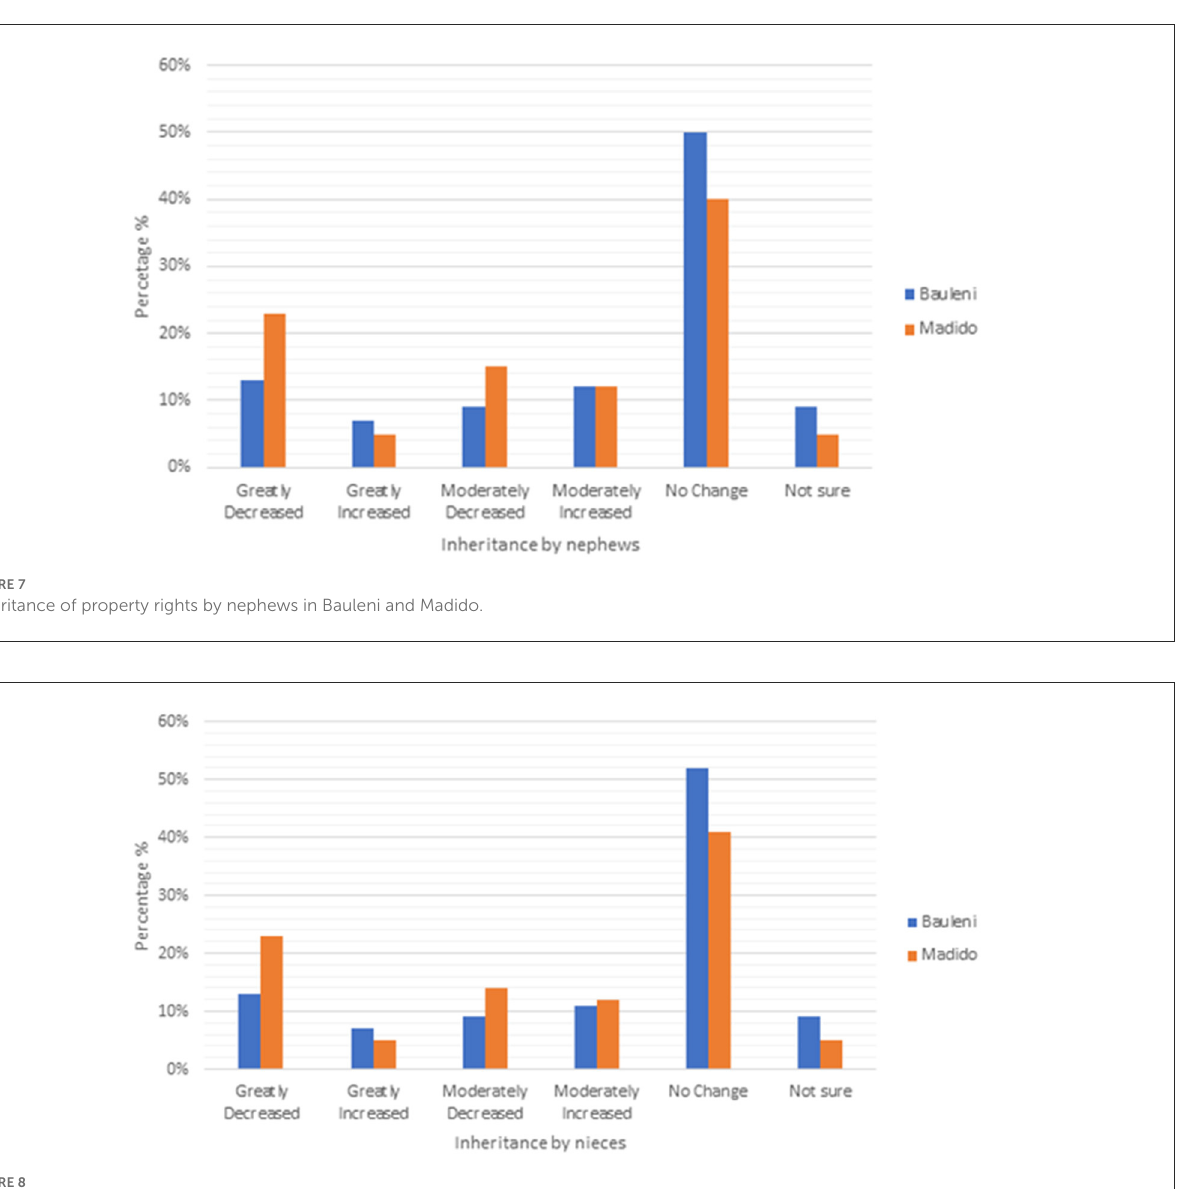
and titling program, implemented alongside the 1999 Law of Succession, and the National Land policy of 2004 resulted in; (i) increased inheritance rights of daughters similar to sons, (ii) permanent land rights for divorced or widowed women, and (iii) increased ability to resist restrictive customary practices, e.g.